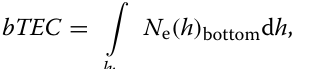
JOEN and RIGA, by numerically integrating the follow- ing equation: